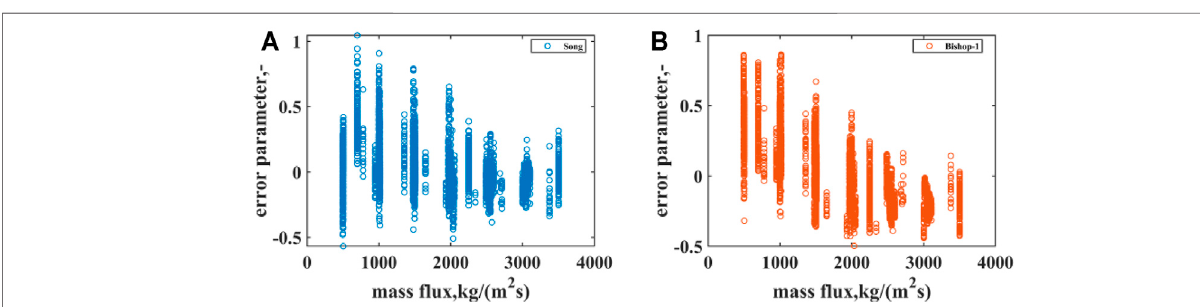
FIGURE 9 | Mean error and RMS error at different reduced pressure range. (A) Mean error. (B) RMS error.